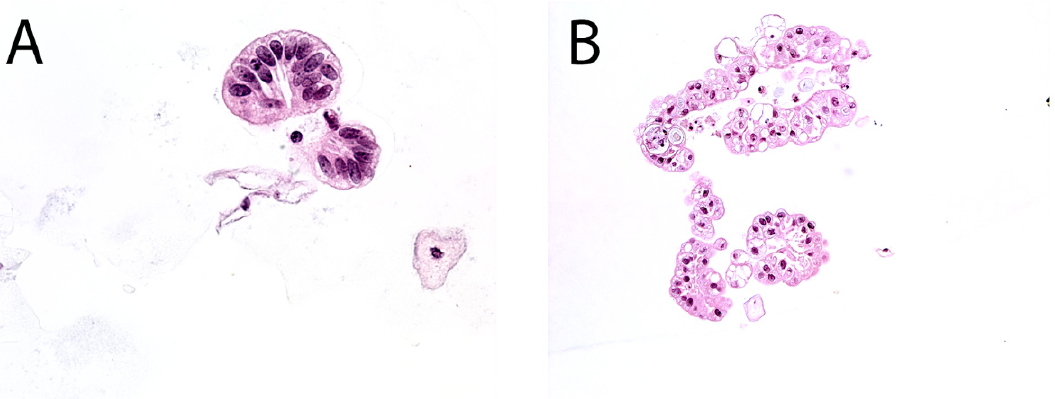
Figure 5. Benign urothelial tissue fragments in cell block preparations. ( A , B ) Examples of benign- appearing urothelial tissue fragments demonstrating bland, uniform nuclei with fine chromatin and moderately abundant cytoplasm from patients who lacked urothelial neoplasia on follow-up.